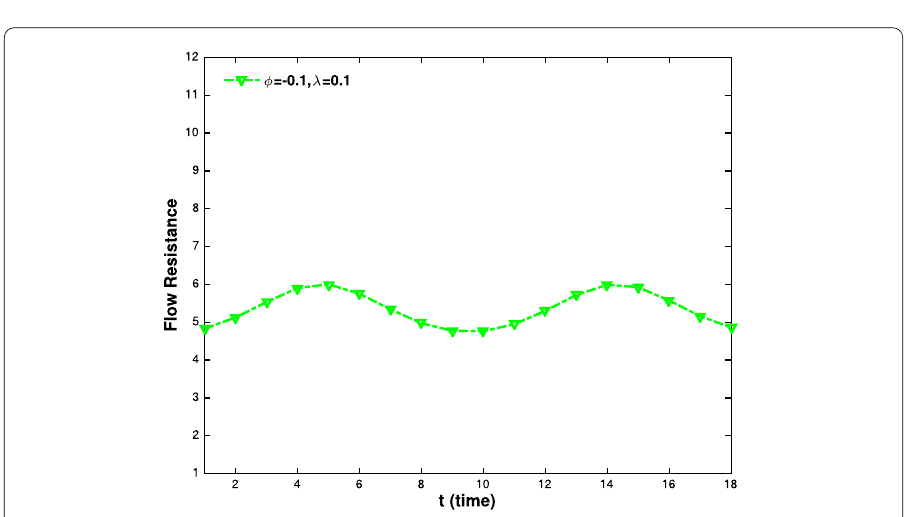
Figure 19 Flow resistance vs time for φ = –0.1 at z = 28, τ y = 0.4, K = 1.6, λ =